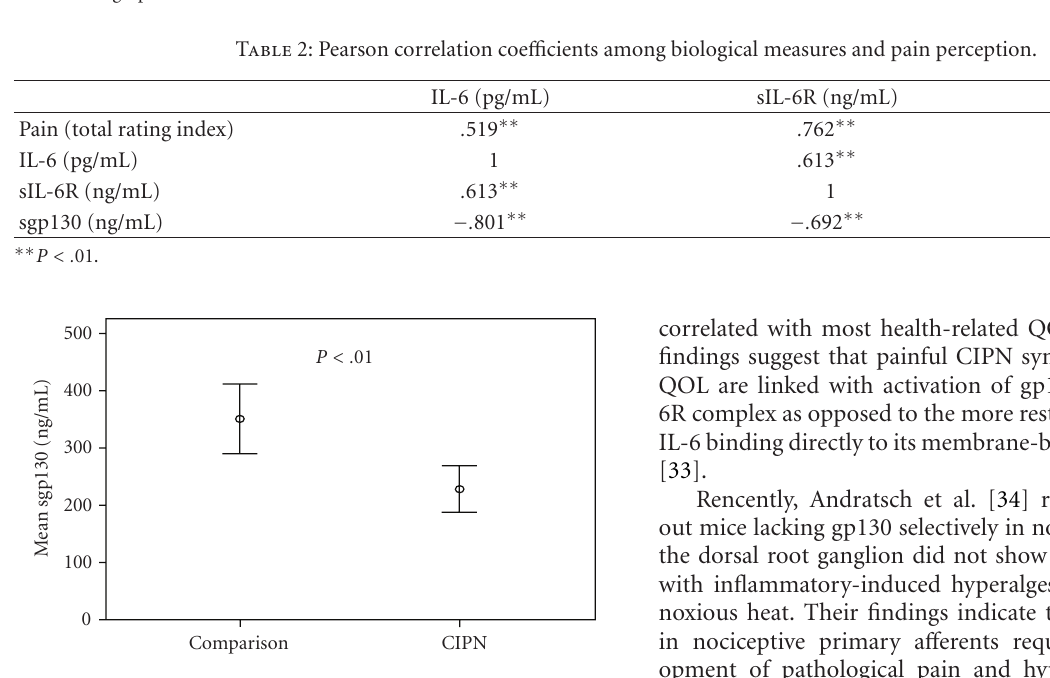
Figure 3: Mean levels of serum soluble gp130 in women with painful CIPN ( N = 20) and women without CIPN symptoms (Comparison Group, N = 20). Dots represent mean value of soluble gp130 (sgp130) measured in serum; error bars repre- sent 95% CI. Mean (SD), [Range] of the Painful CIPN group: 228.3 (112.7)ng/mL [198–263]; Comparison group: 350.8 (119.9) ng/mL [290–407]. Independent t -test with Bonferroni correction performed to examine di ff erence between groups: ( t (38) = 4.2, P < .